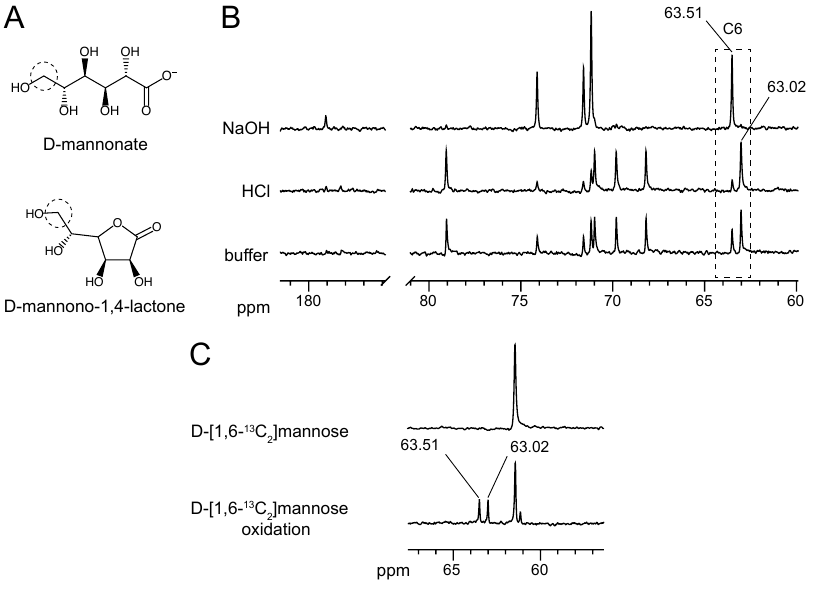
Figure 4. Analysis of D-mannono-1,4-lactone under different conditions and products of AldT-mediated oxidation of isotope labelled D-mannose. ( A ) Chemical structures of the free sugar acid, D-mannonate, and its lactone, D-mannono-1,4-lactone. Carbon 6, which was used to differentiate the two different substrate forms in NMR spectra, is circled for both structures. ( B ) Decoupled 1D 13 C NMR spectra of D-mannono-1,4-lactone after incubation in 1 M NaOH, 1 M HCl and in 0.1 M sodium phosphate (NaP) buffer pH 7. Chemical shift for carbon 6 is shown by a dashed rectangle. Characteristic chemical shifts for the lactone (63.02 ppm) and for the free sugar acid (63.51 ppm) are indicated. ( C ) Decoupled 1D 13 C NMR spectra before ( top ) and after ( bottom ) oxidation of labelled D-mannose with AldT. Chemical shifts of carbon 6 for lactone and free sugar acid are